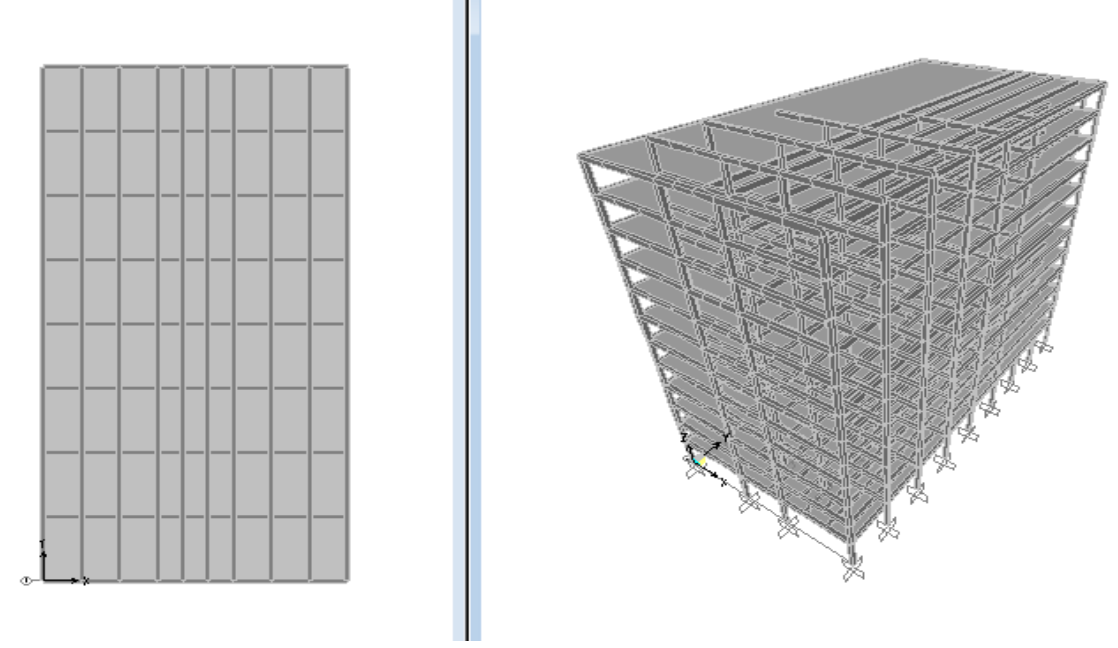
Figure 3. 3D views of the 12-story model in ETABS.